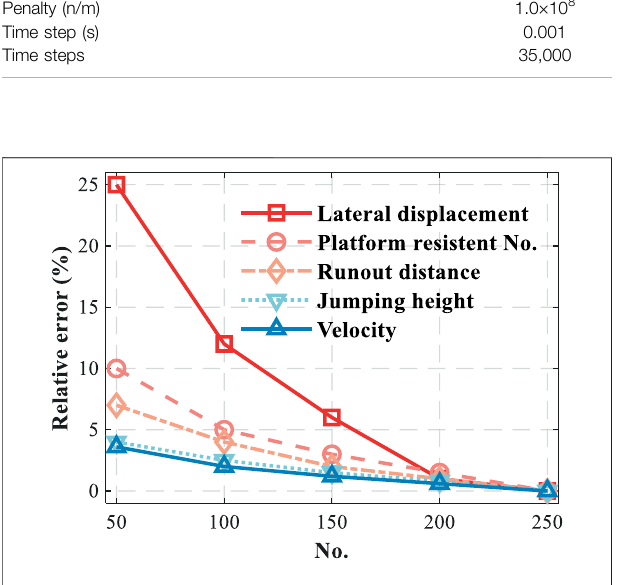
FIGURE 8 | Relationship between relative error and No. of